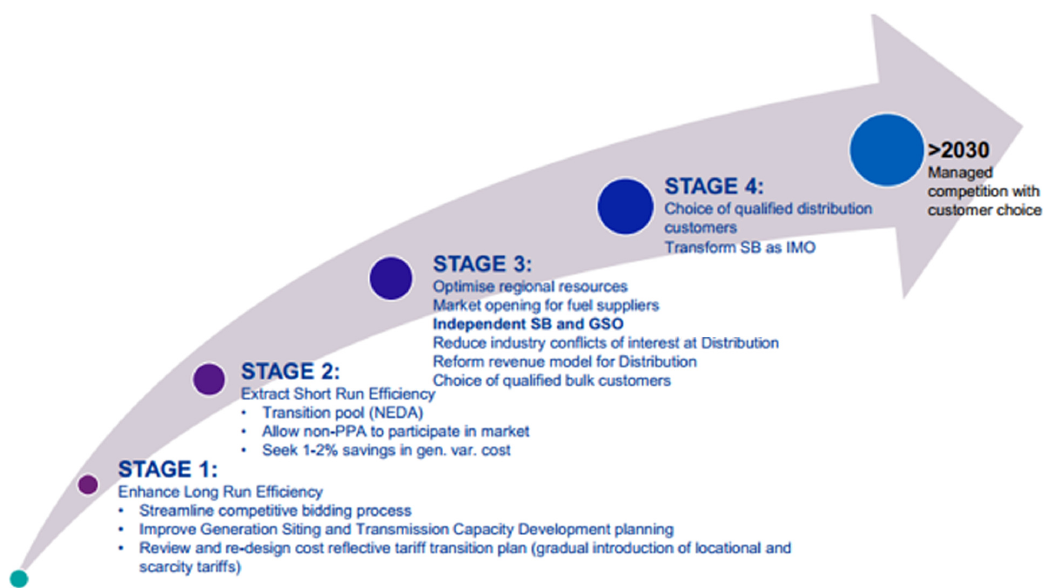
Figure 4. Malaysia electricity supply industry (MESI) roadmap—https://www.singlebuyer.com.my/